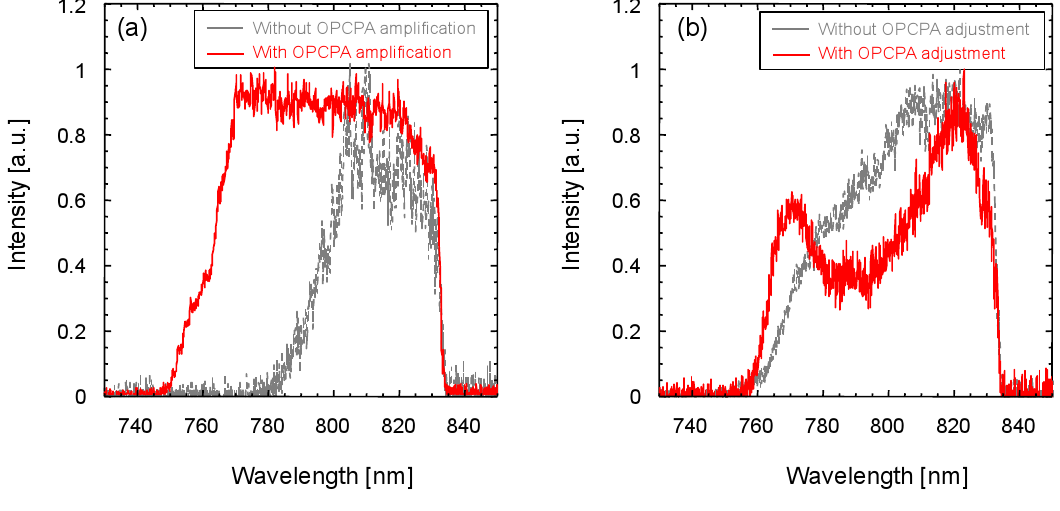
Figure 3. ( a ) Amplified output spectra after OPCPA preamplifier stage with (solid red curve) and without (dashed gray curve) OPCPA amplification; ( b ) Amplified output spectra after second saturable absorber with (solid red curve) and without (dashed gray curve) OPCPA